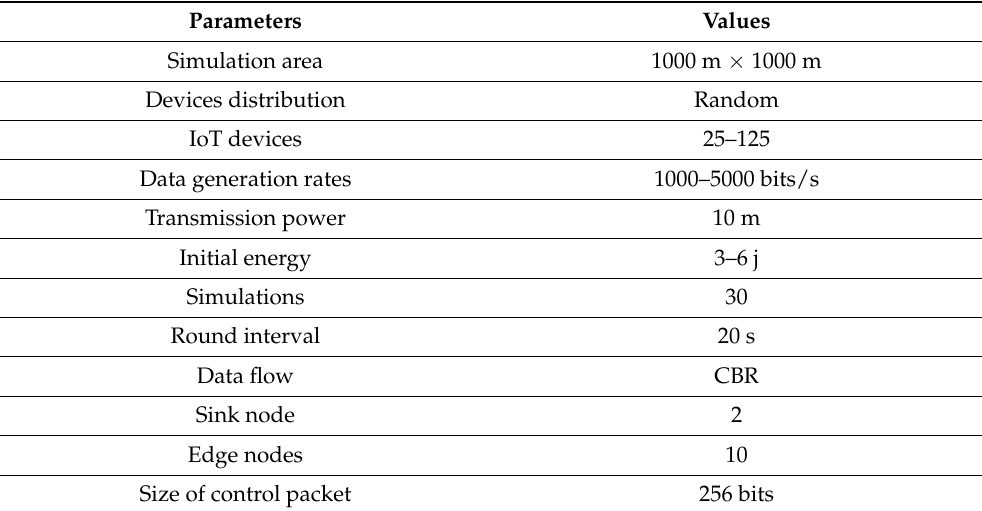
Table 1. List of simulation